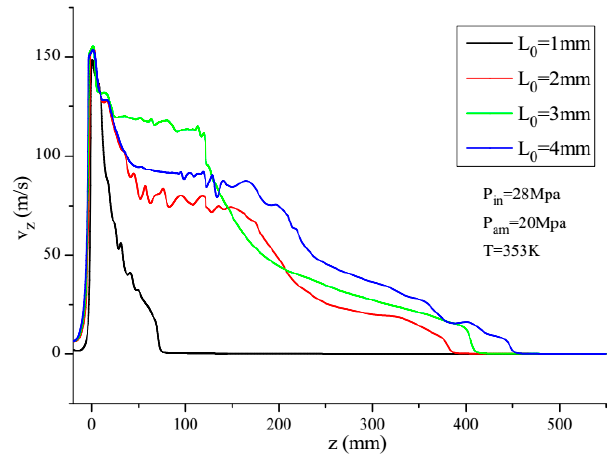
Figure 12. The e ff ect of nozzle outlet length on the axial velocity of SC-CO 2 Figure 12. The effect of nozzle outlet length on the axial velocity of SC-CO 2 jet.